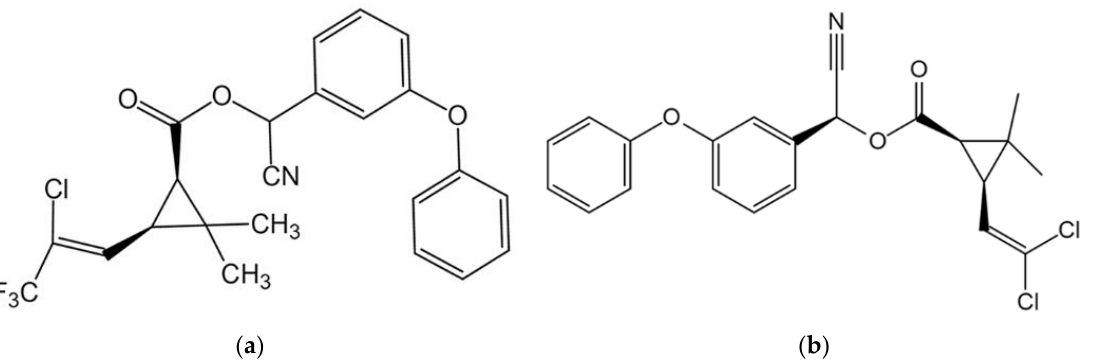
Figure 1. The chemical molecular structures of pesticides. ( a ) Lambda-cyhalothrin; ( b ) Beta- cypermethrin.